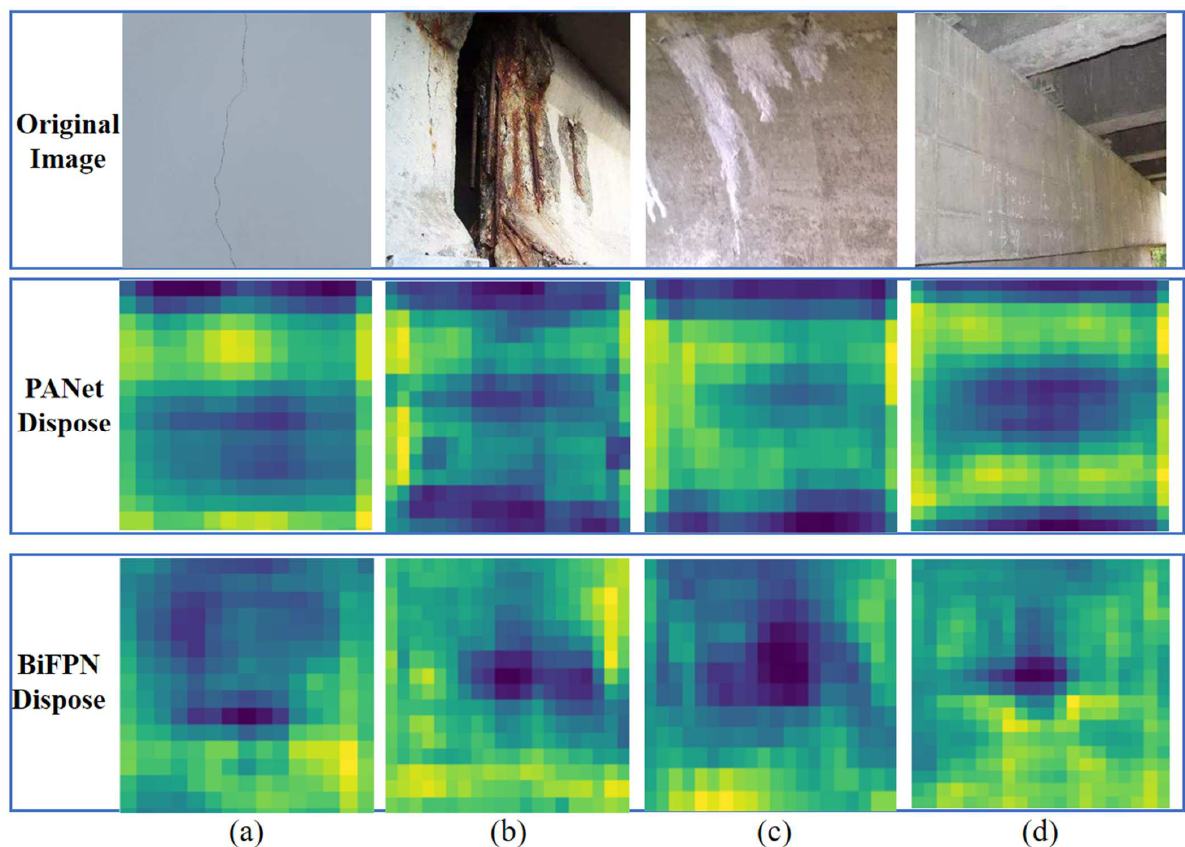
Figure 4. Damage feature extraction map of PANet and BiFPN bridge structures. ( a – d ) are the feature extraction of the four types of damage under the PANet and BiFPN network structures, respectively.)